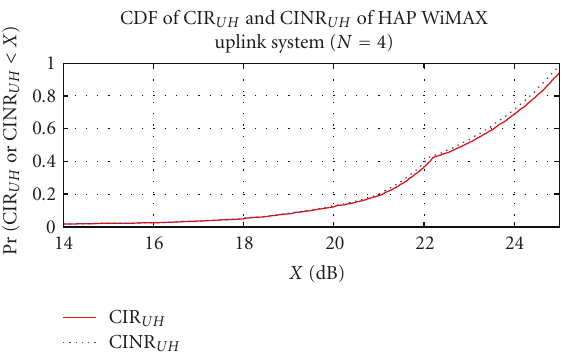
Figure 10: CDF of uplink CIR and CINR performance in a HAP uplink system with reuse factor =